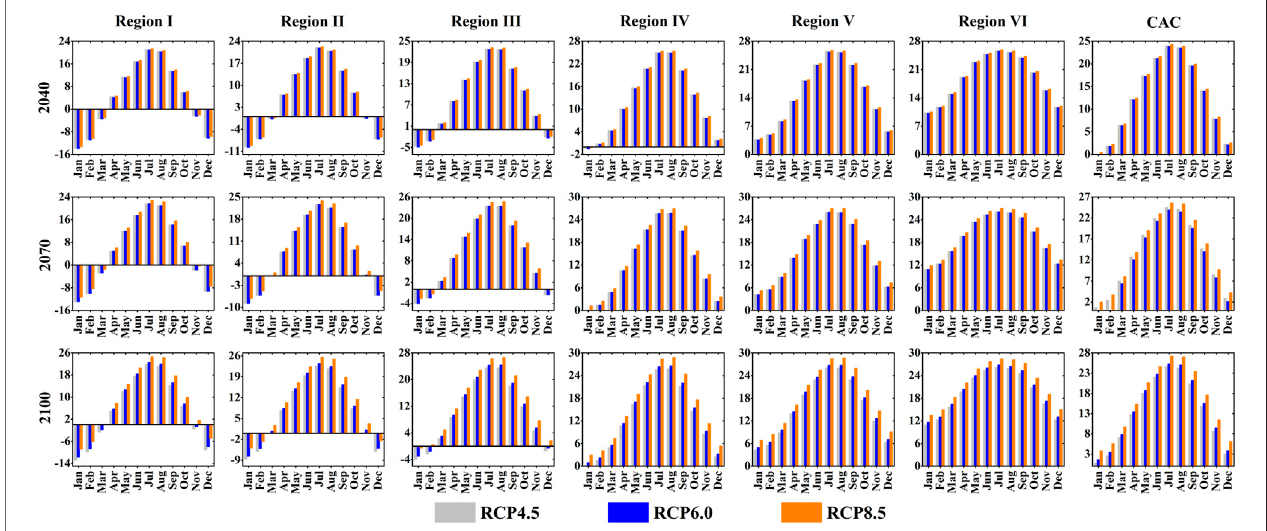
FIGURE 8 | Projected monthly average Tmin for 2040, 2070, and 2100 with different RCPs over CAC.